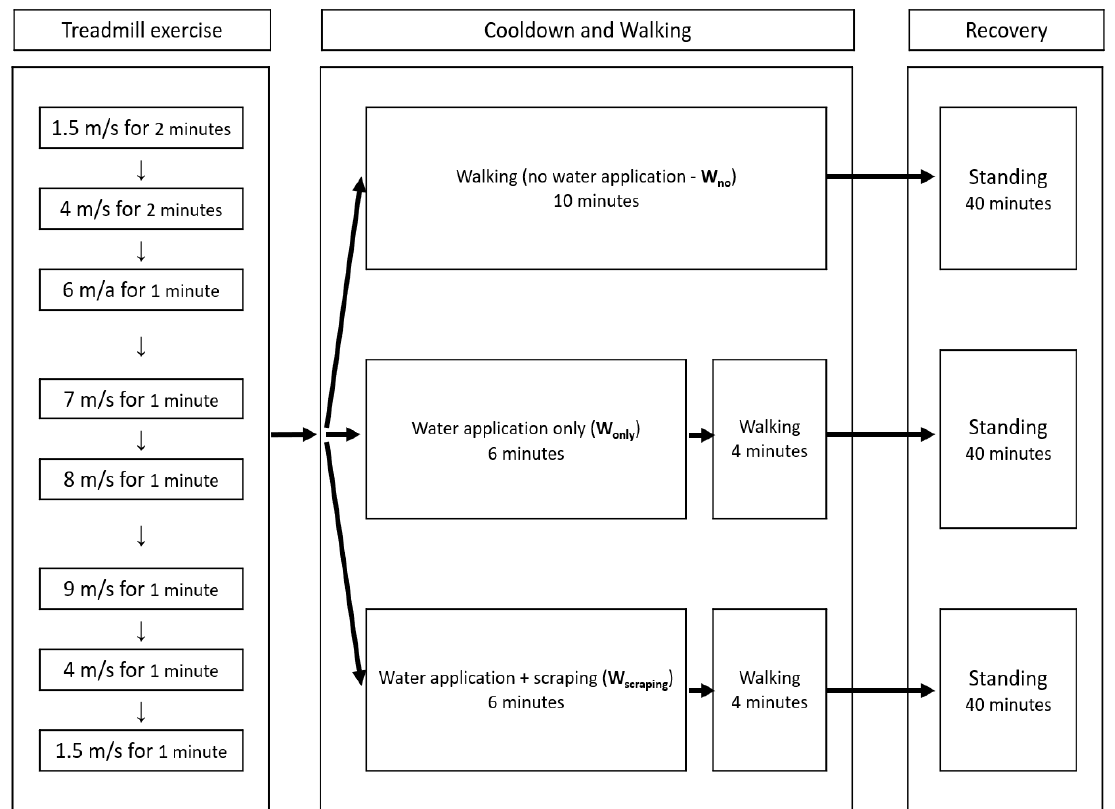
Figure 2. Exercise and cool-down program during the data collection period.